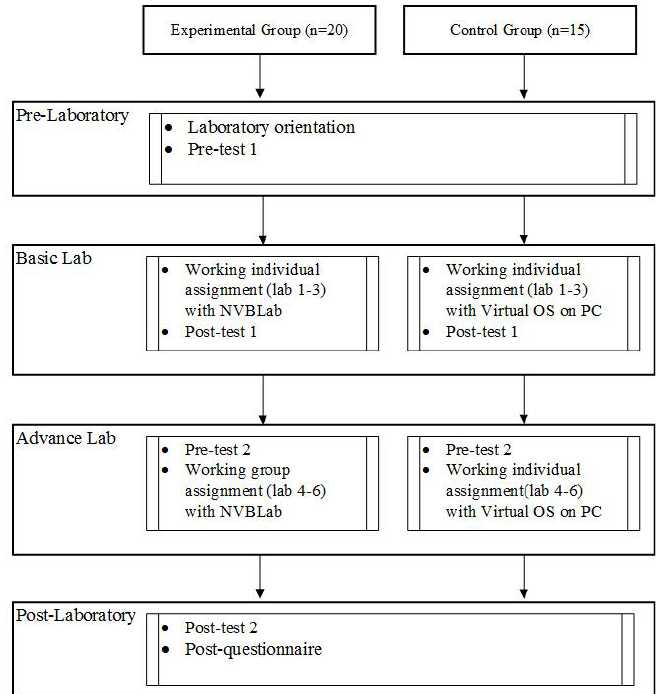
Figure 1. Flow chart for the